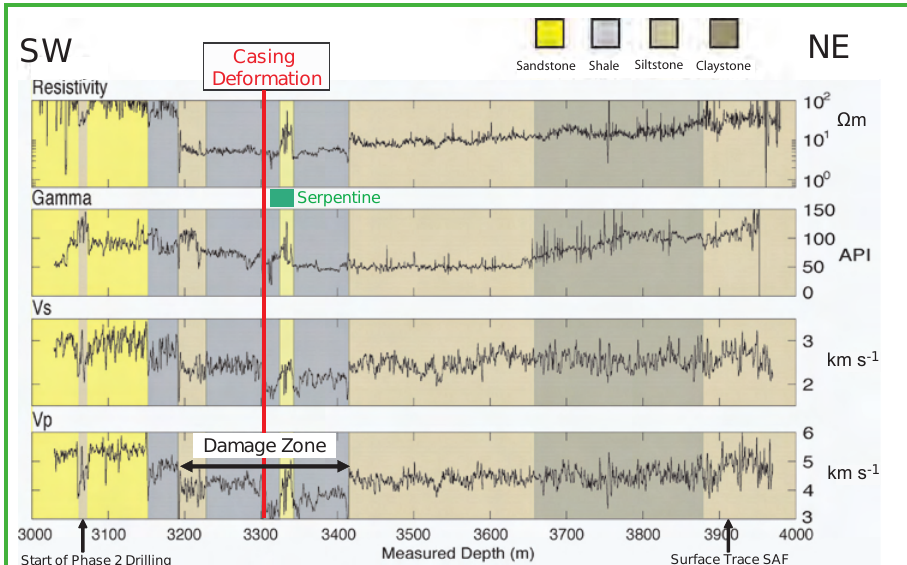
Figure 3. Geophysical well logs acquired across the San Andreas fault zone during SAFOD Phase 2, superimposed on major lithologies derived from cuttings analysis. Depths are as measured along the borehole, which is inclined at an angle of 54º–60° from the vertical (see Figure 2C for reference). Also shown are zones of casing deformation revealed by repeat multi-finger caliper logging (corresponding to an active trace of the fault at a measured depth of ~3300 m) and a ~200-m-wide damage zone defined by anomalously low P- and S-wave velocities and resistivity. Analyses of cuttings reveal the occurrence of serpentine (shown in green) and talc just to the northeast of the casing deformation